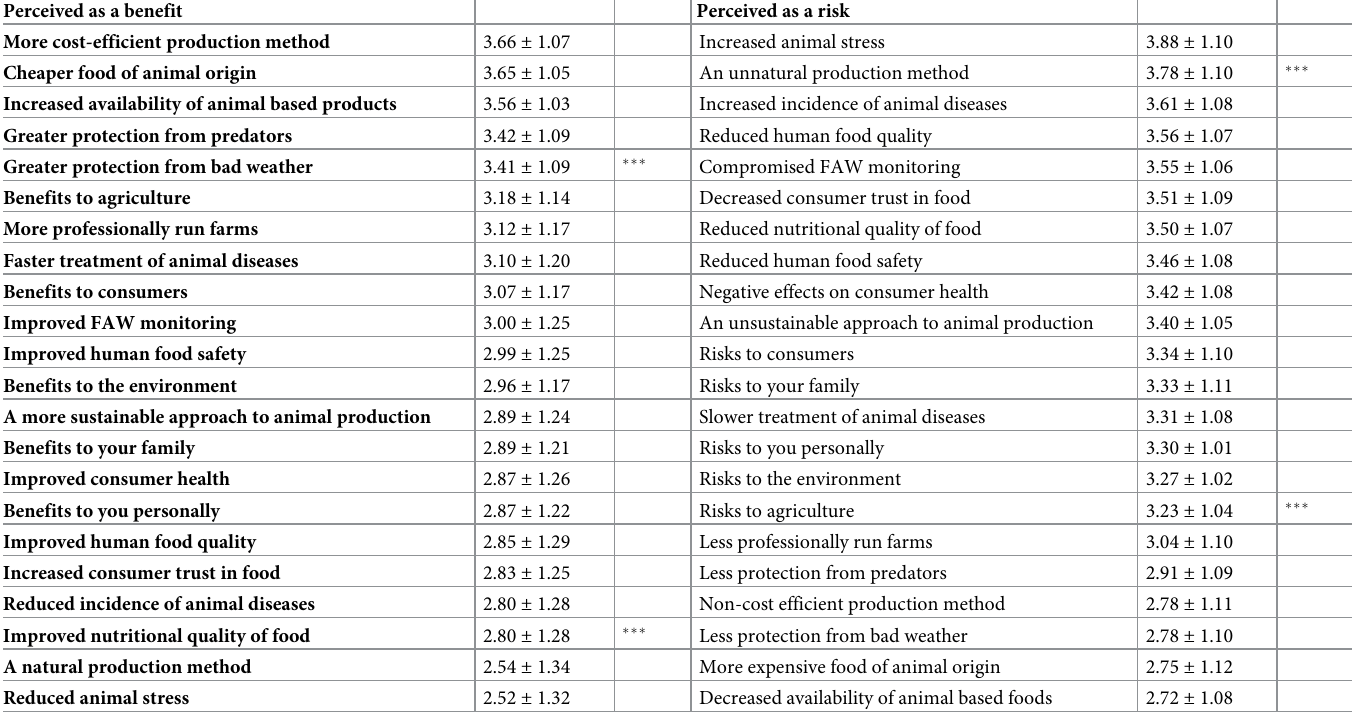
Table 4. Risk and benefit perceptions of respondents in the five study countries regarding intensive pig production systems (mean response on a linear scale 1 (strongly disagree) to 5 (strongly agree) ± SD; n =